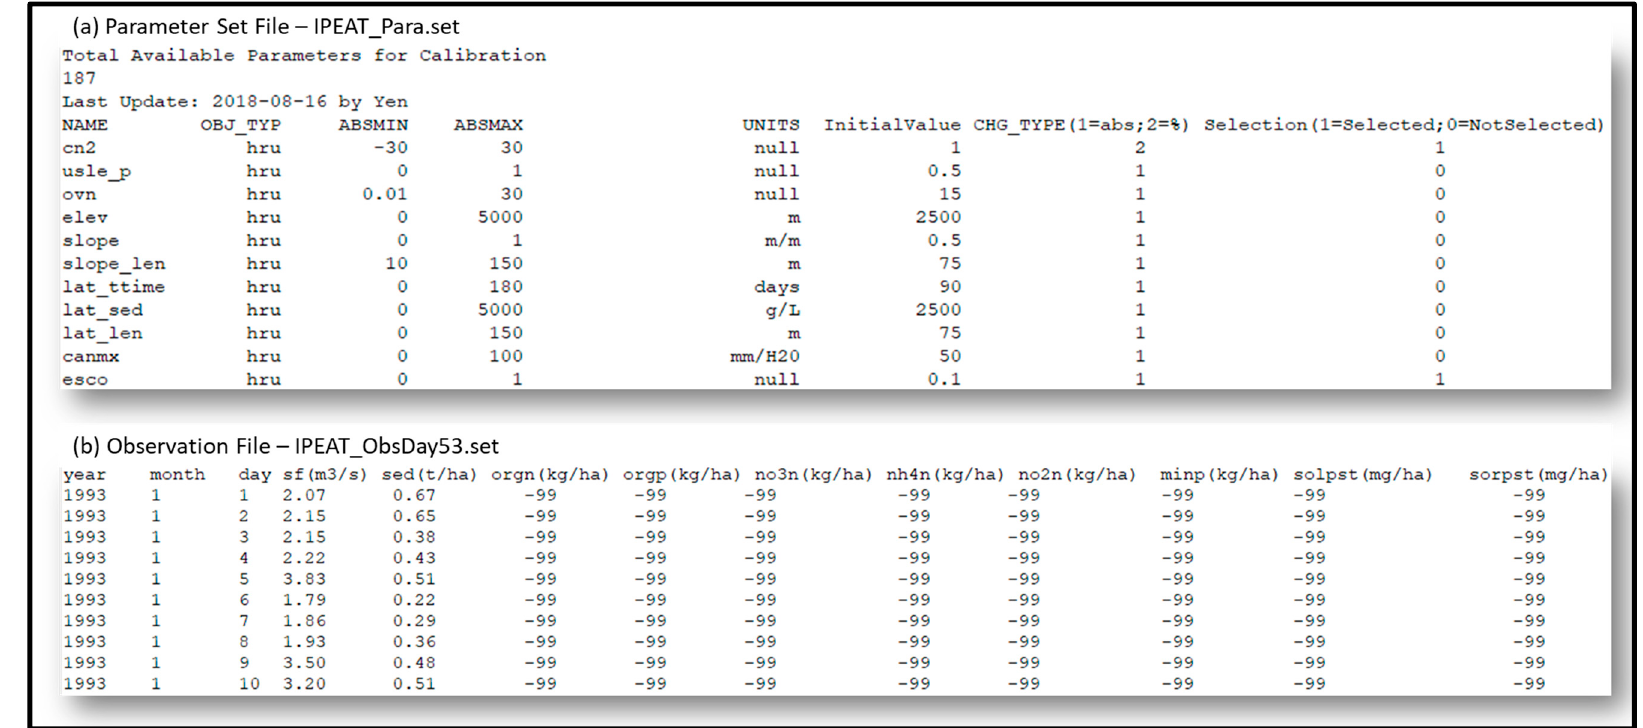
Figure 3. Illustration of IPEAT+ input files: ( a ) parameter setting file for automatic calibration in IPEAT_Para.set; and, ( b ) example of observation data file at daily time step .